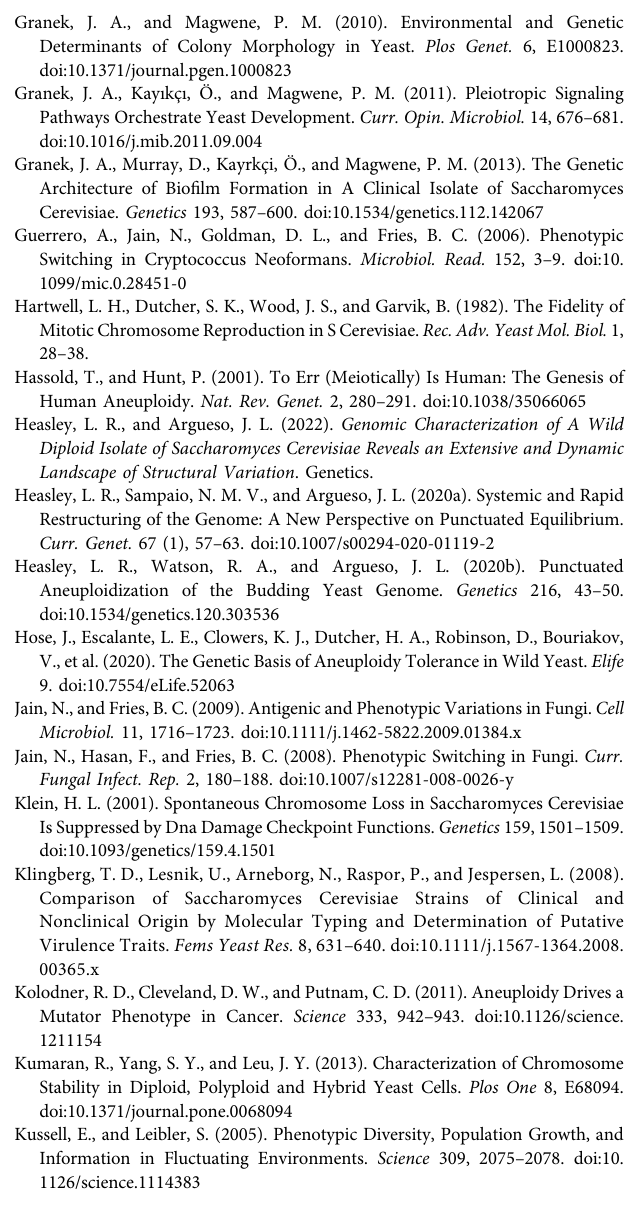
Supplementary Table S2 | Karyotypic analysis of variant genomes. Supplementary Table S3 | Fluctuation analysis derived rates of Chr5 loss in YJM311 and JAY3106 backgrounds. Supplementary Table S4 | Karyotypic analysis of MA